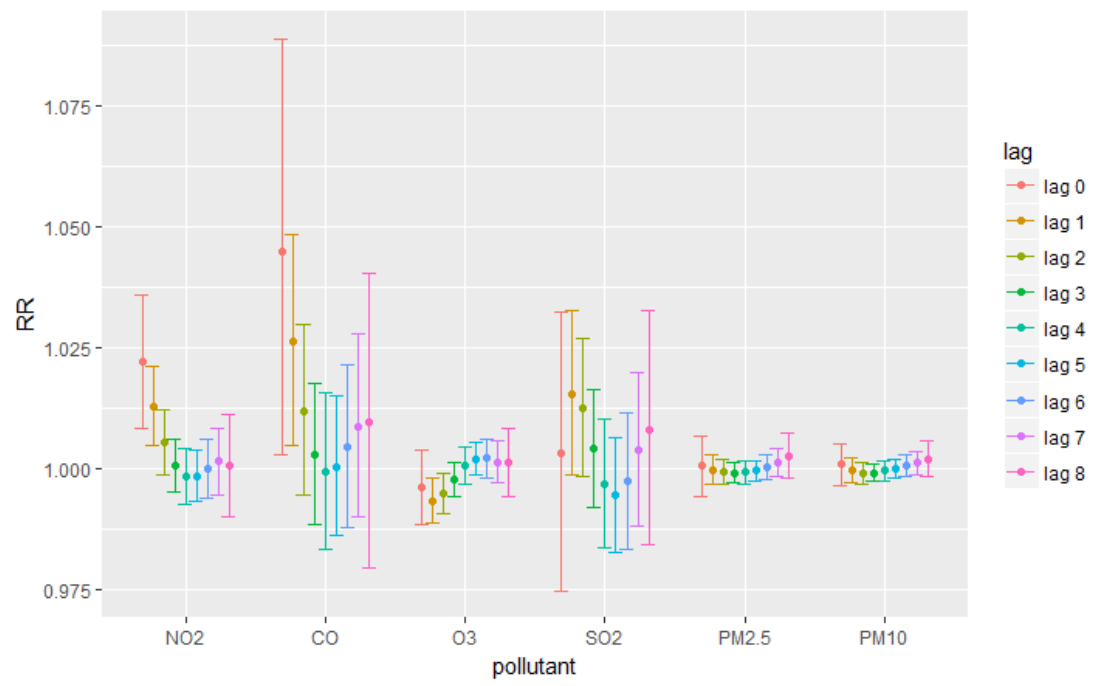
Figure 1. Relative Risks for each pollutant at each lag.